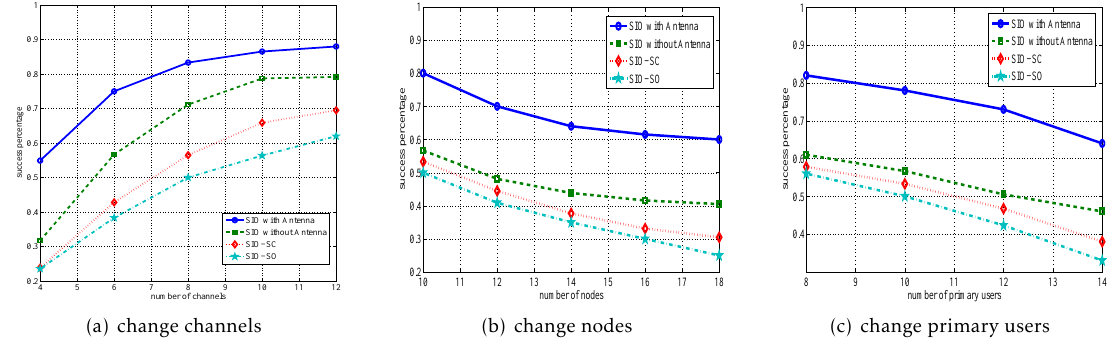
Figure 4. Comparison of success percentage when varying network settings.